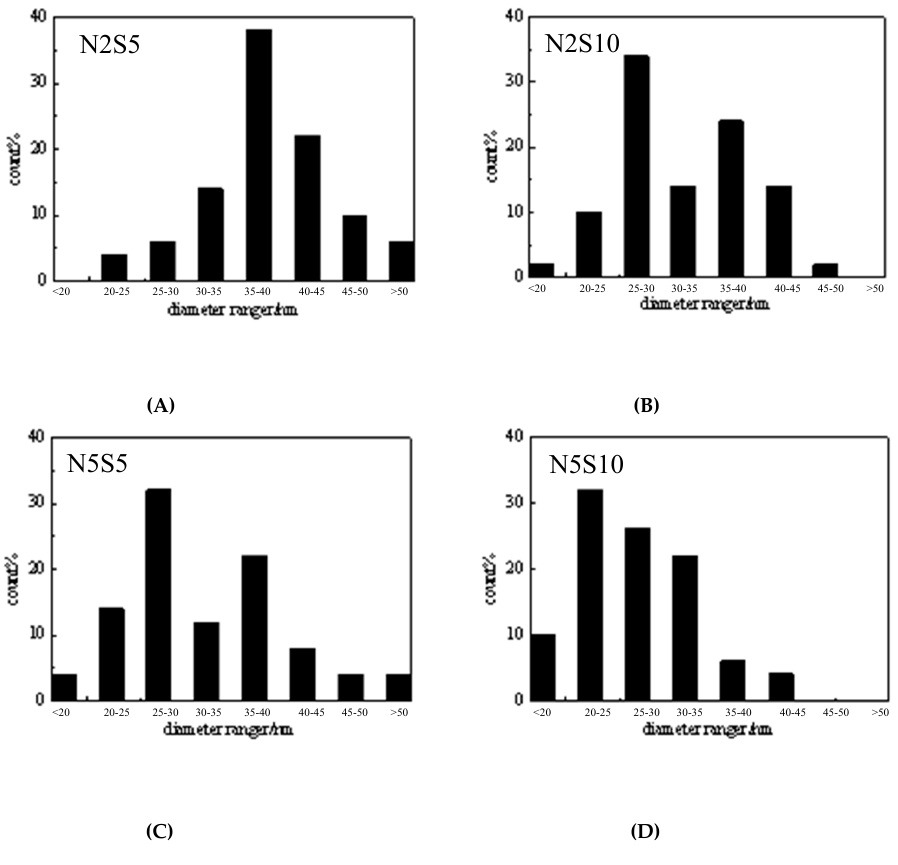
Figure 6. Size distribution map of PCF cellulose nanofibers. (N2S5( A ): 2 wt% NaOH and 5 min sonication, N5S5( B ): 5 wt% NaOH and 5 min sonication N2S10( C ): 2 wt% NaOH and 10 min sonication, N5S10( D ): 5 wt% NaOH and 10 min sonication).